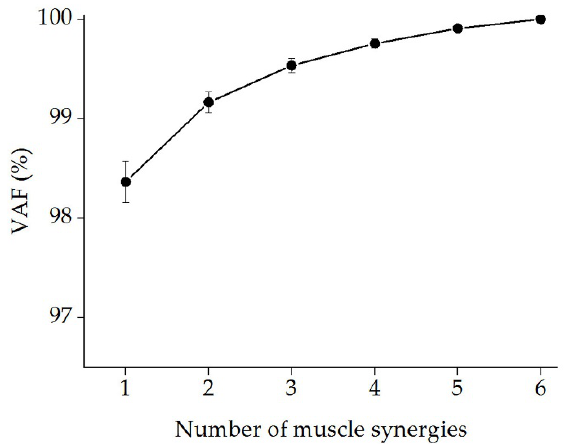
Figure 5. The relationship between the mean Variability Accounted For (VAF (%)) and the number of muscle synergies. The mean global VAFs were calculated using pooled data from all participants. According to criteria defined in Section 2.4.2, the optimal number of synergies was determined as s = 1.